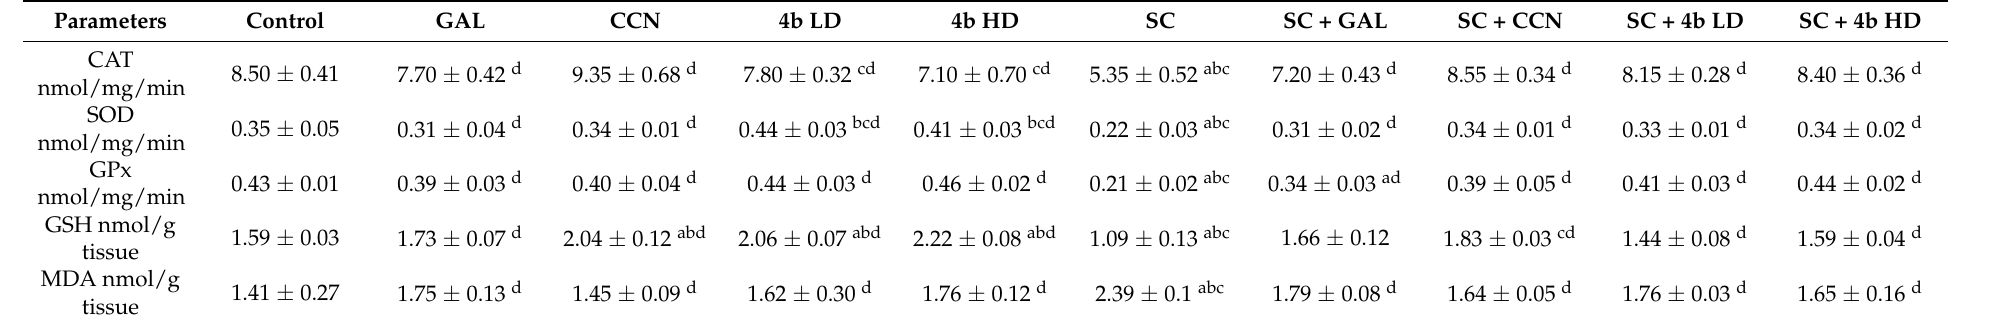
Table 1. Oxidative stress biomarkers for GAL, CCN and 4b (two doses) alone and in combination with SC. Results are expressed as mean ± SD (n = 4). The significance of the data was assessed using the nonparametric Mann–Whitney U test. Values of p ≤ 0.05 were considered statistically